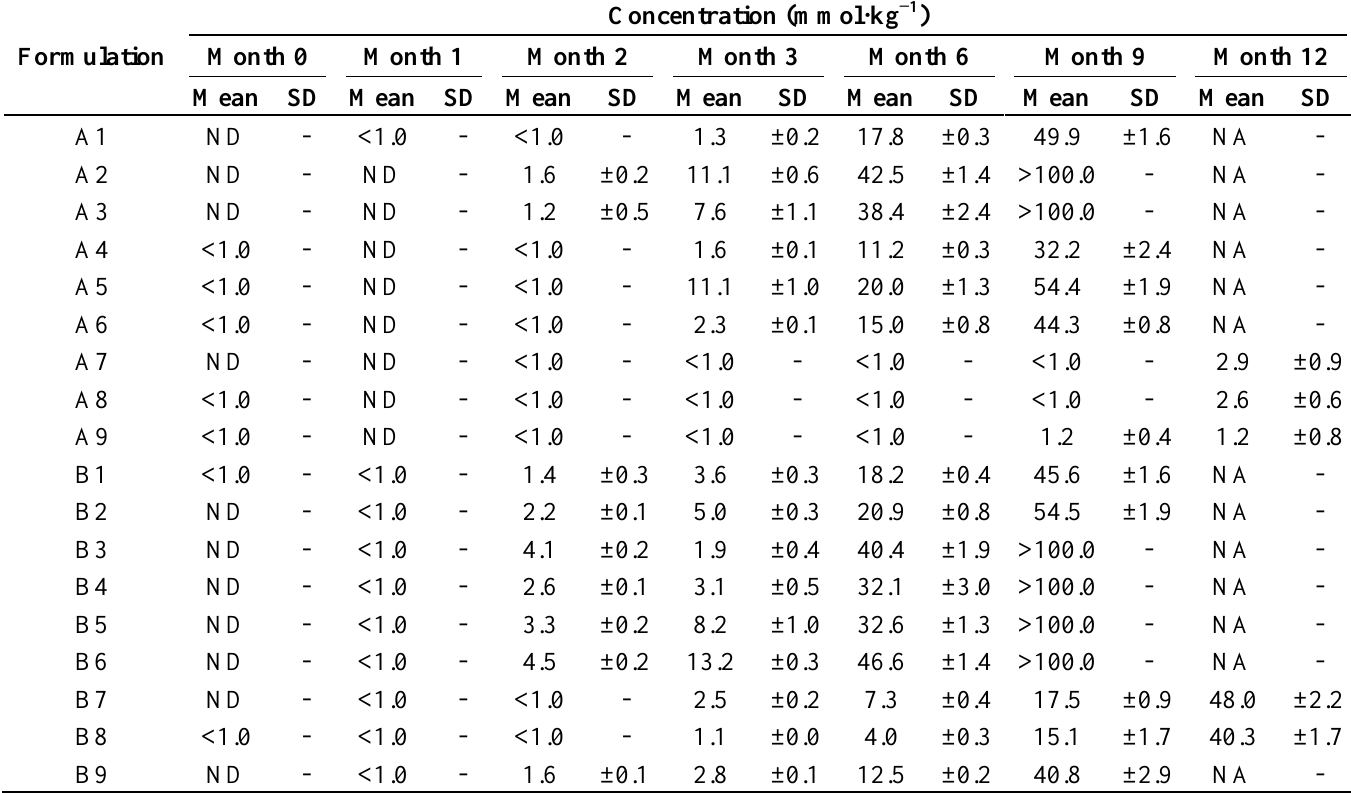
Table 9. Analysis of lipid hydroperoxides in infant formulations with and without antioxidants via thiocyanate assay.